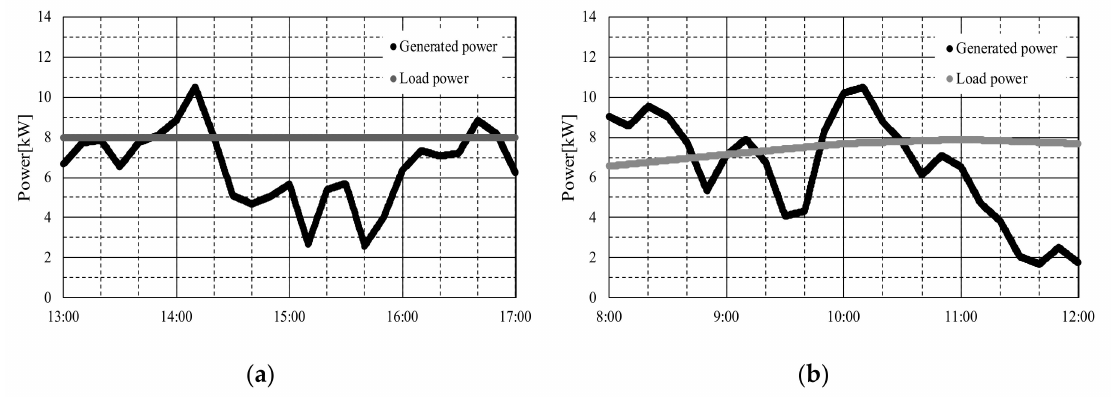
Figure 14. Estimated generation power of a wind power plant: ( a ) with a constant load and ( b ) with a variable